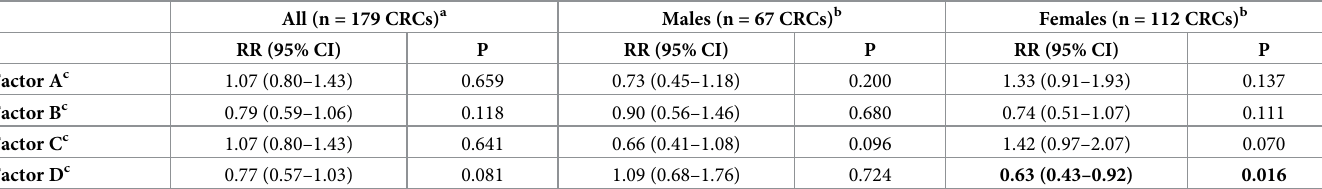
Table 4. RRs and 95% CIs for colorectal cancer by intervention group in all trial participants and by